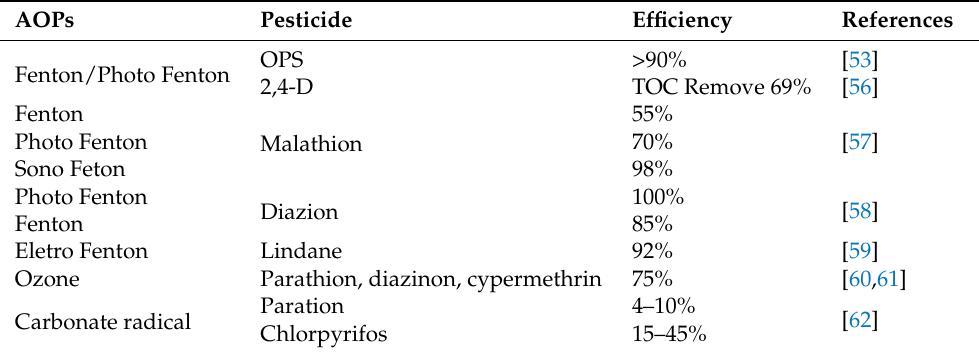
Table 2. Efficiencies of AOPs in pesticide